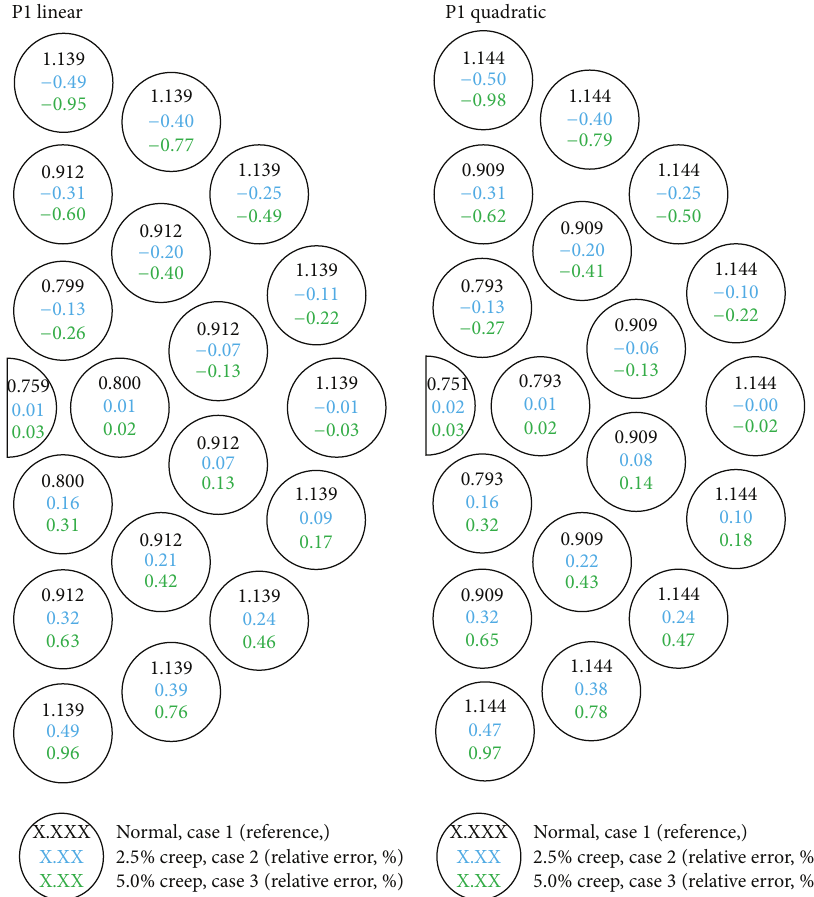
Figure 6: Relative errors of pin power with creep of the TRIAINA-P1